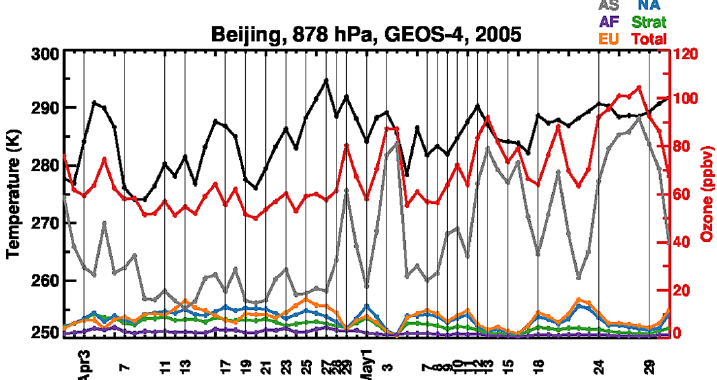
Figure 8. Time series of O 3 concentrations (ppbv, red line) and temperature (black line) at 878hPa over Beijing in the GEOS-Chem model driven by the GEOS-4 meteorological fields. Also shown in the panel are simulated concentrations (ppbv) of tagged O 3 produced in the Asian (AS, grey line), African (AF, purple line), European (EU, orange line), and North American (NA, blue line) troposphere and O 3 transported from the stratosphere (Strat, green line). Vertical lines indicate dates with ozonesonde soundings and/or aircraft measurements.